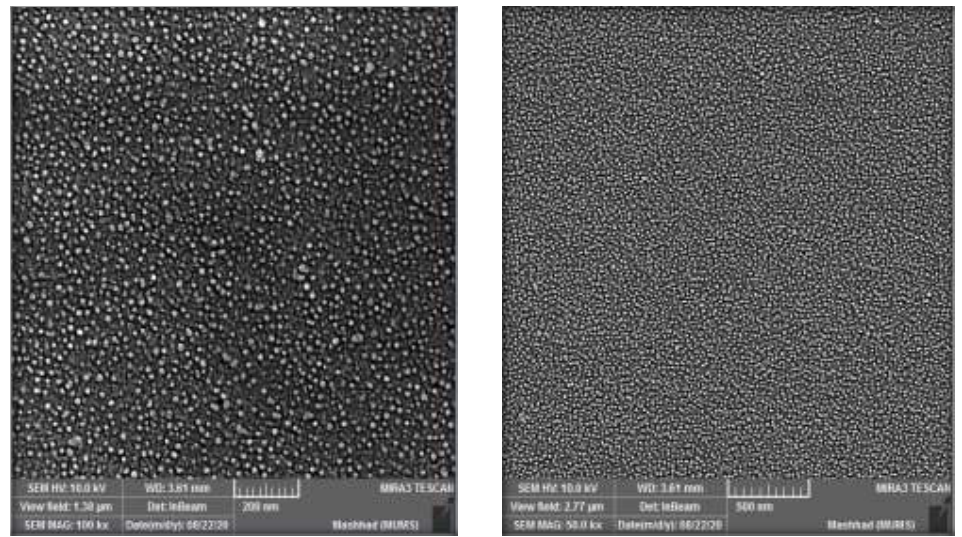
Fig.3: SEM images TiO